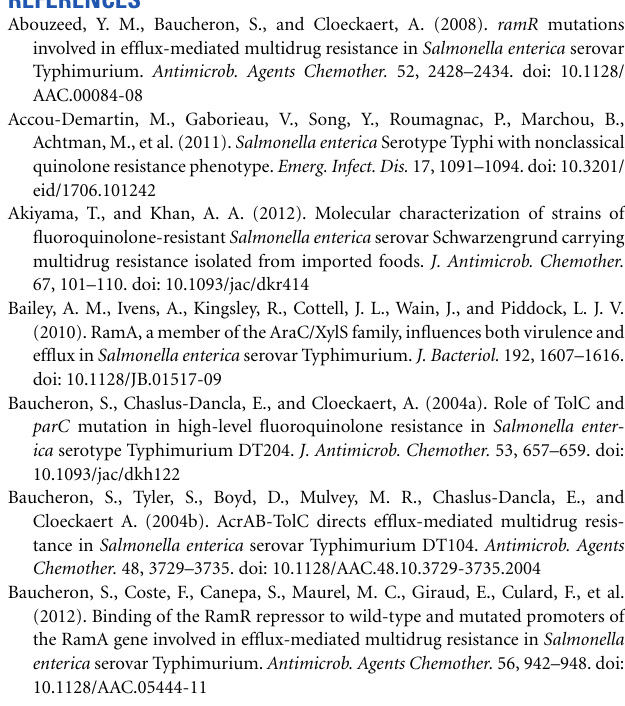
S . Typhi strain LT2 (GenBank NC_003197.1). Small black arrows indicate primers positions used for PCR to amplify and sequence the acrSE region. The 2334 bp chromosomal deletion was found in all S . Typhi strains